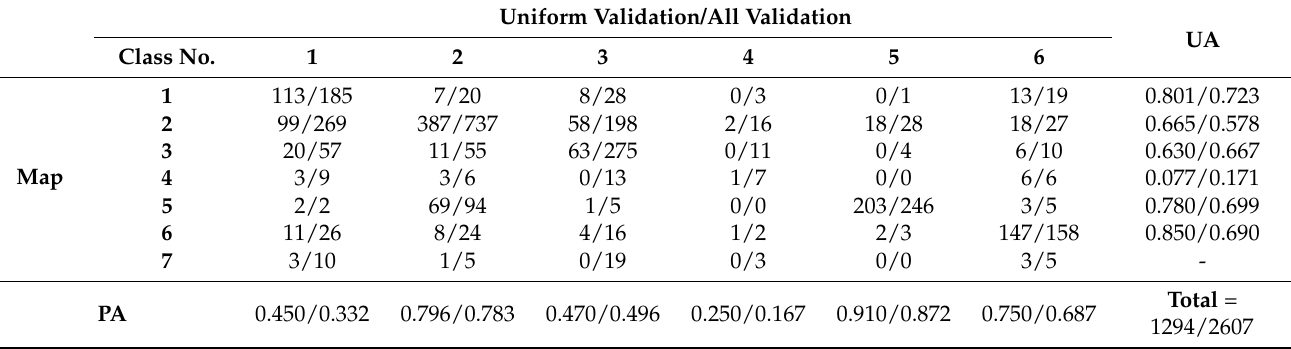
Table 11. Confusion matrix for MCD12 in 990 m scale.